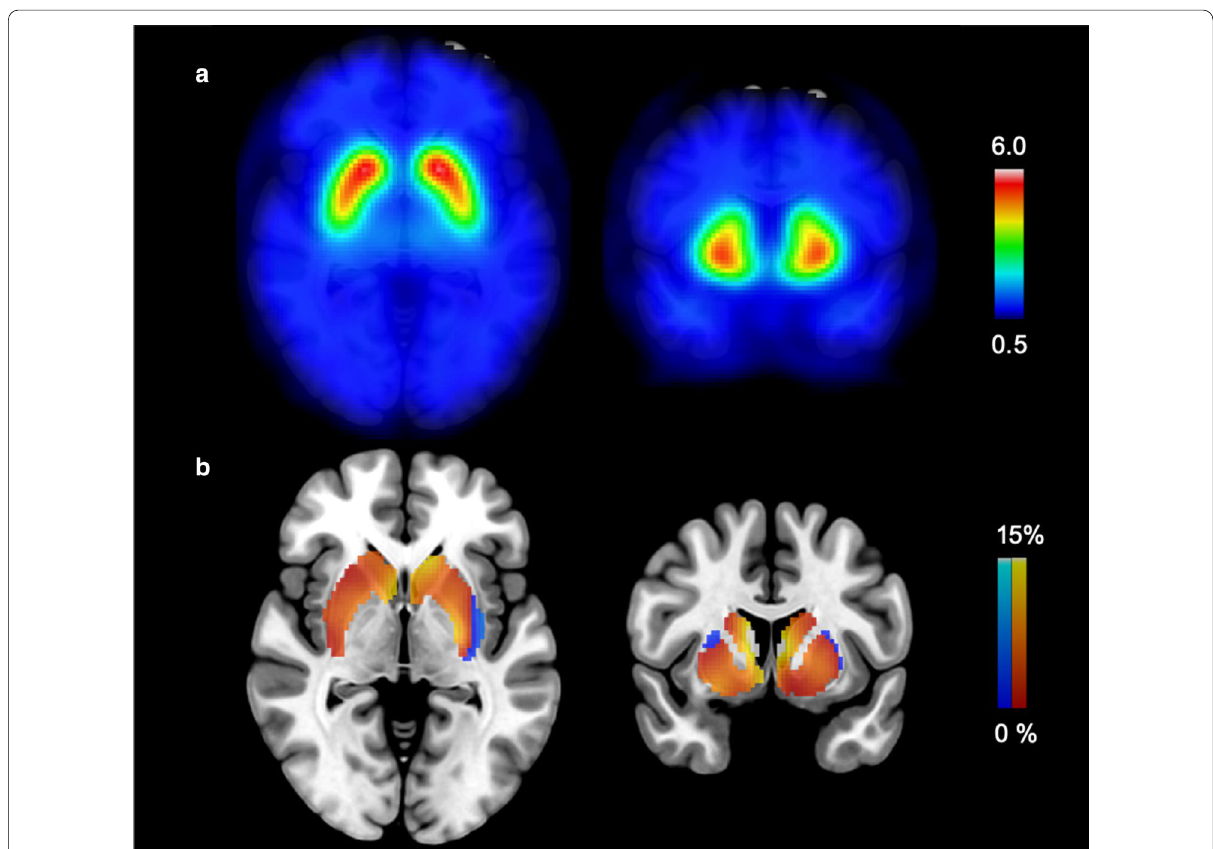
Fig. 3 Voxelwise map of sex differences in the striatum. A Average SBR age-corrected SBR 1 difference between men and women. Red-yellow scale indicates regions with higher and blue-light scale lower uptake in + women compared to